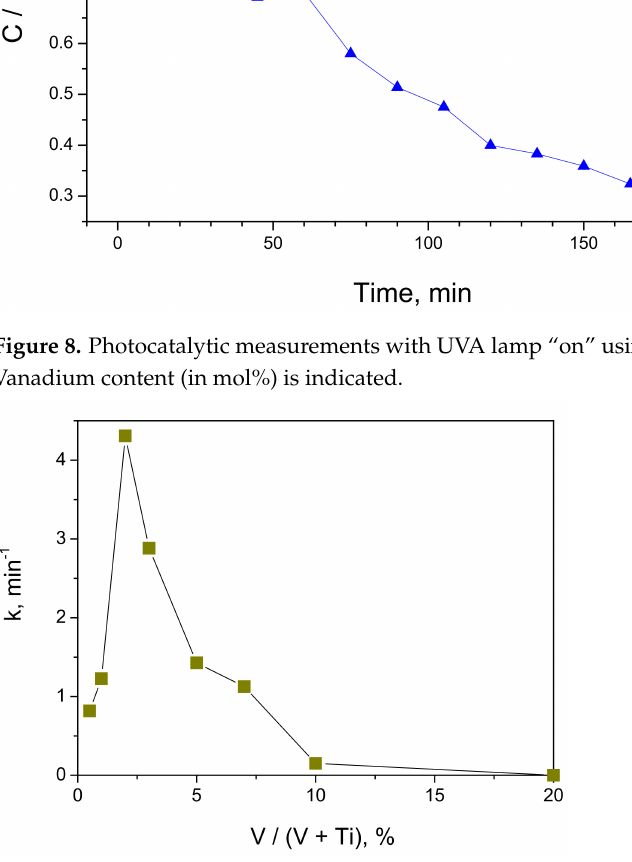
Figure 9. Rate constant of photocatalytic decomposition of MB with UVA lamp illumination ( λ = 365 nm) versus vanadium content in V-TiO 2 coated glass